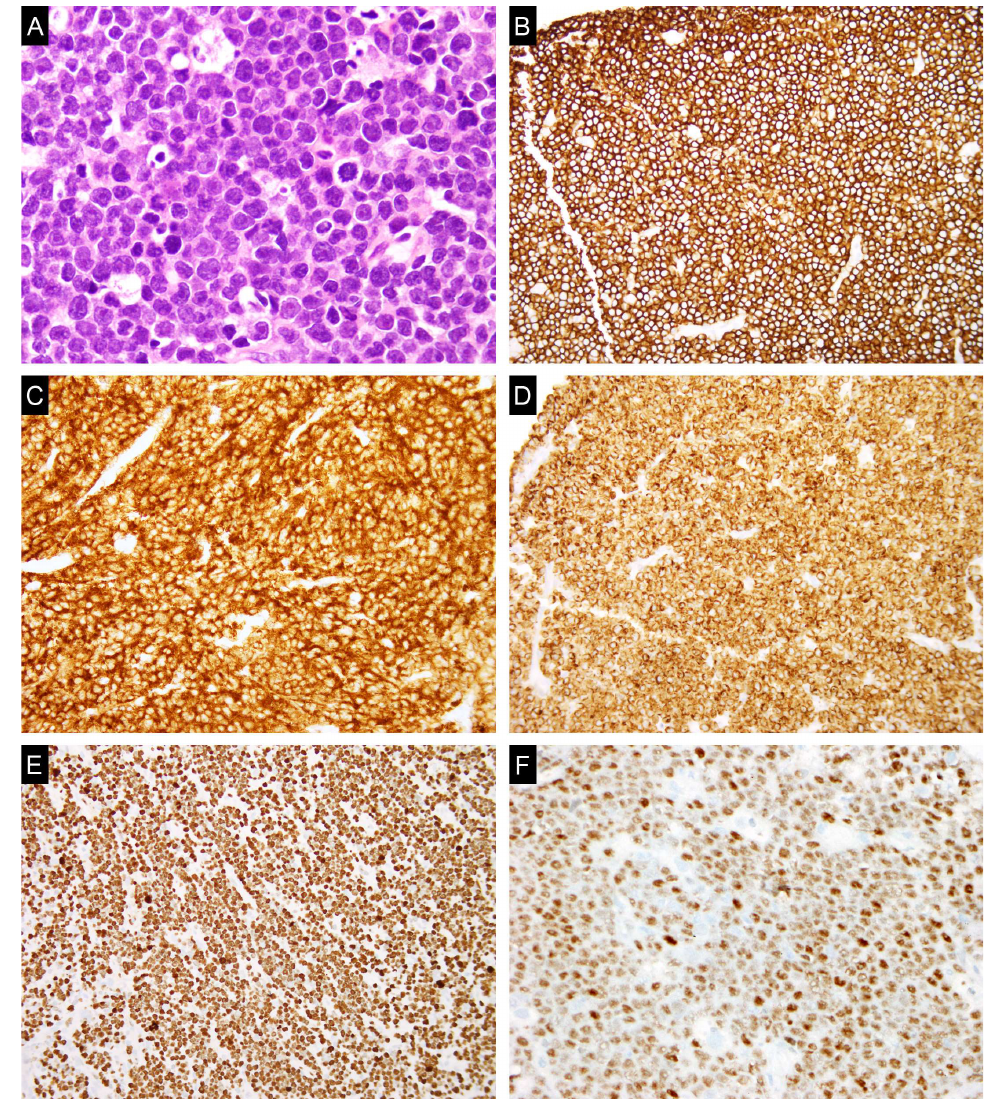
Figure 1. A typical case of double-hit lymphoma (DHL). ( A ) Hematoxylin and eosin (H&E) section shows sheets of medium-sized lymphoid cells with blastoid chromatin and mitotic figures. The lymphoma cells are positive for B-cell marker cluster differentiation 20 (CD20) ( B ), germinal center marker (cluster differentiation 10 (CD10) ( C ), B-cell lymphoma protein 2 (BCL2) ( D ), and c-MYC ( F ), and show a high proliferation rate by Ki-67 (>90%) ( E ).